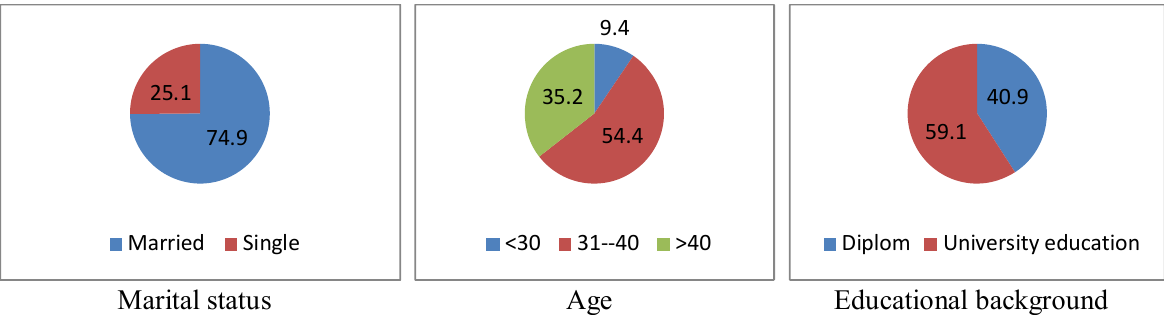
Fig. 2. Personal characteristics of the participants